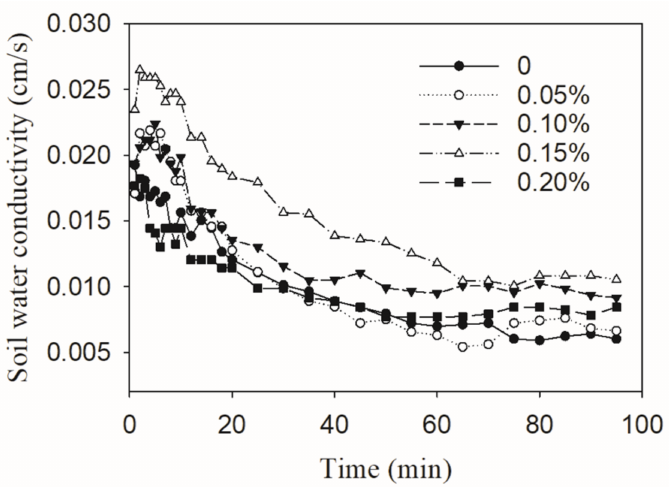
Figure 4. Variation characteristics of water conductivity of complex soil under different BM addition ratios. The percentage represents the mass ratio of BM